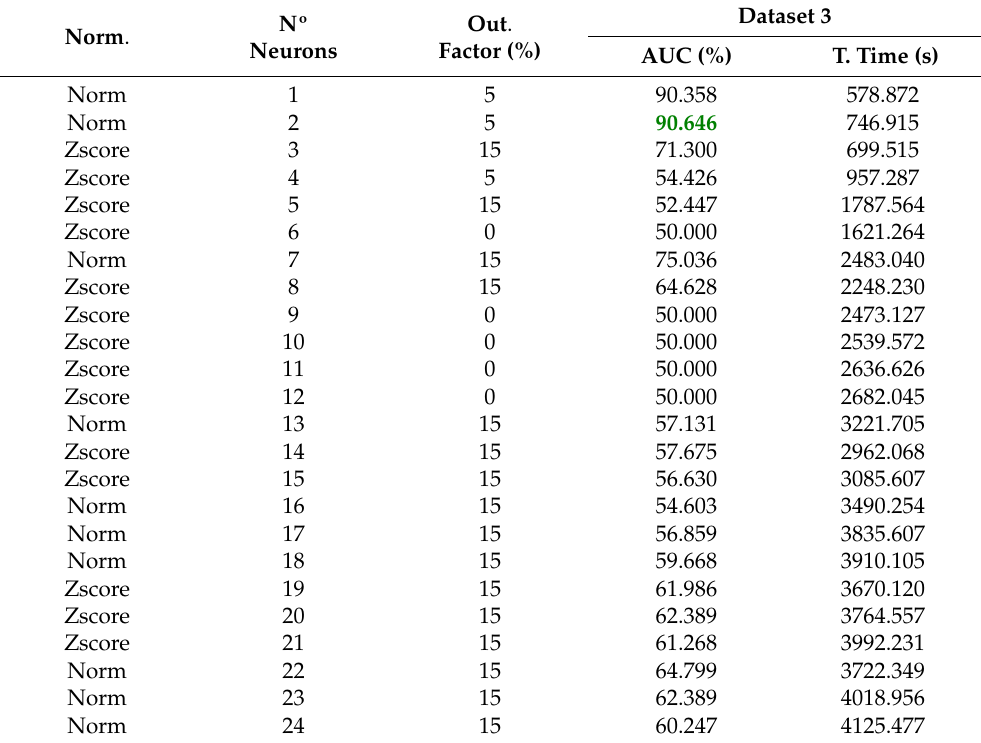
Table 7. Autoencoder results for dataset